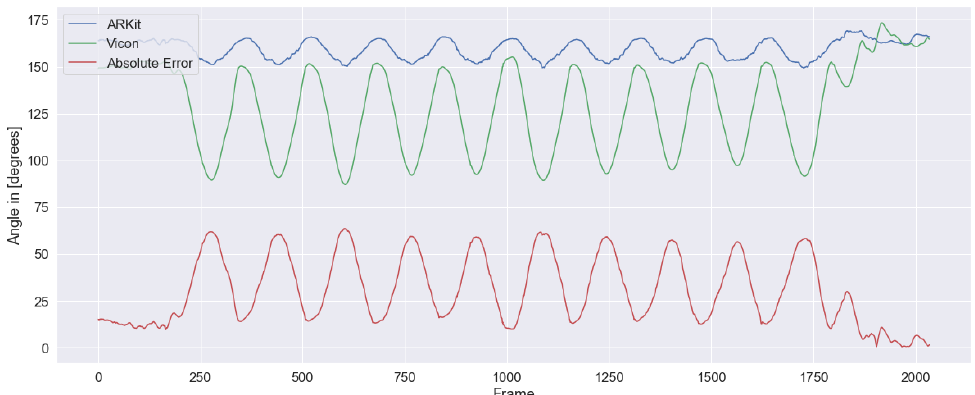
Figure 7. Left hip angle of one of the subjects in the Side Squat exercise in degrees. The plot shows that while the motion pattern is visible in both recordings, ARKit exposes a reduced amplitude and a shift on the y -axis.